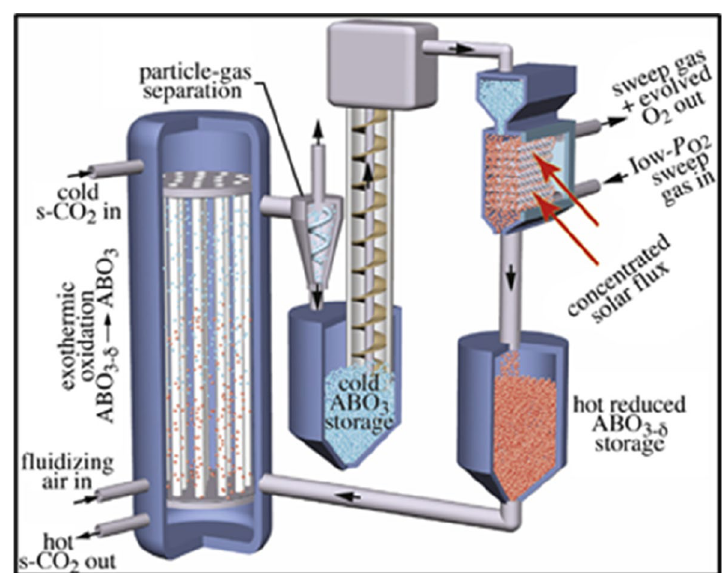
Fig. 16 The air-fed fluidized bed integrated with a solar receiver